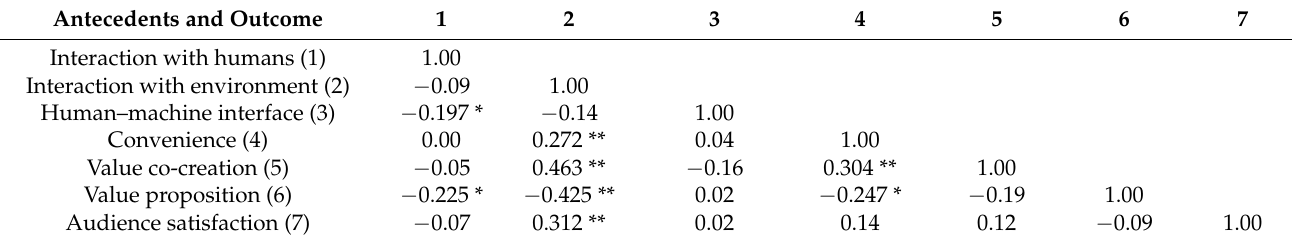
Table 4. Correlations of